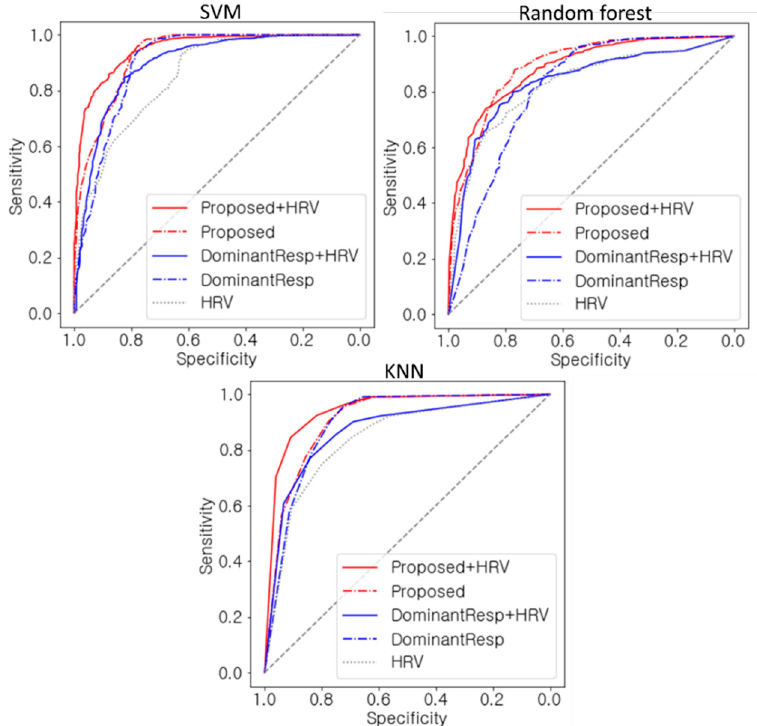
Figure 8. ROC graphs of different prediction models using five different feature sets. Here, the sensitivity corresponds to the ability of predicting the actual ‘drowsy’ epoch as ‘drowsy’. The specificity corresponds to the ability of predicting the actual ‘wake’ epoch as ‘wake’.